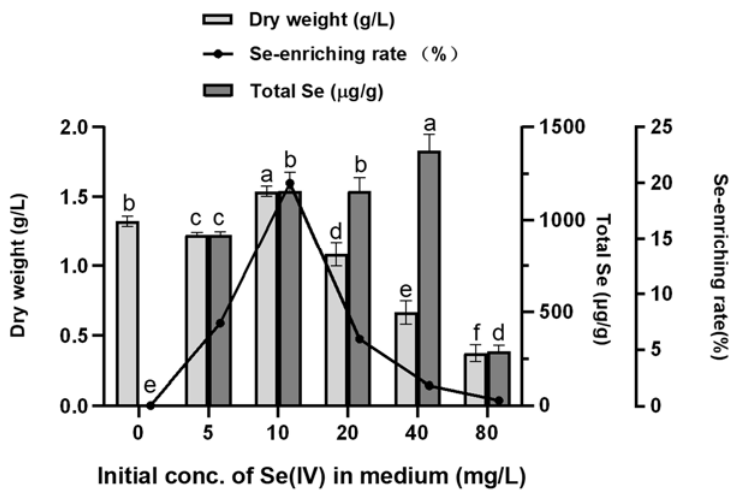
Figure 4. Biomass and selenium-enriching capacity of A. camphorata at di ff erent concentrations of initial Se (IV). Values with le tt ers a, b, c, d, e, and f are signi fi cantly di ff erent across columns ( p <